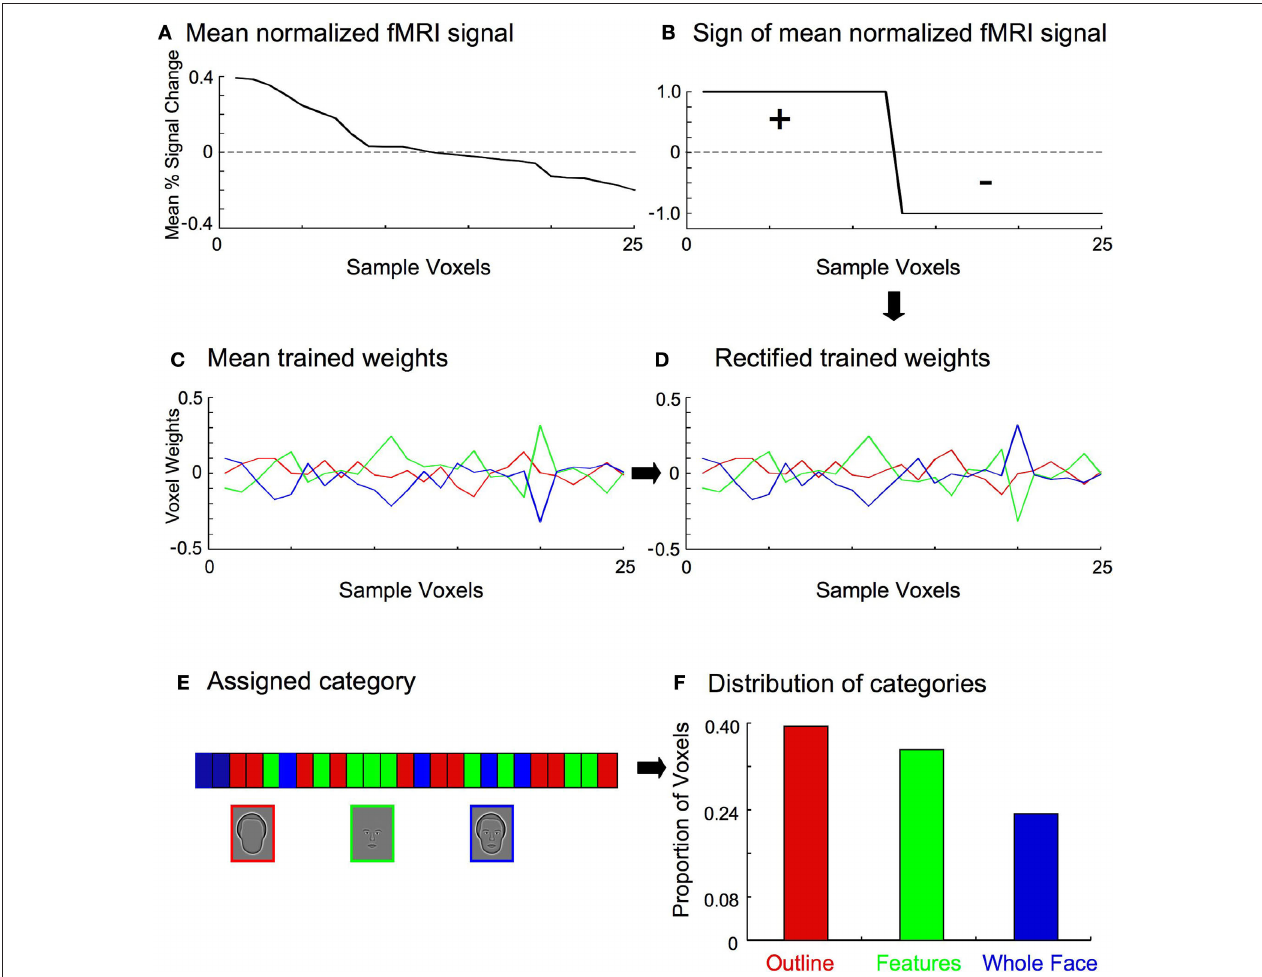
Figure 5 | Stages in determining the category to which a particular voxel contributed most positively. For clarity, a small set of 25 example voxels is shown here. (A) The fMRI responses (percent signal change from baseline) for the 25 voxels were averaged across all training samples and categories. (B) The sign of the mean fMRI activation was recorded for each voxel. (C) The multi-class classifiers from all training sets (see Figure 4 ) were averaged to determine the mean weights for each category, indicating the relative contribution of each voxel to the discriminatory information for a particular